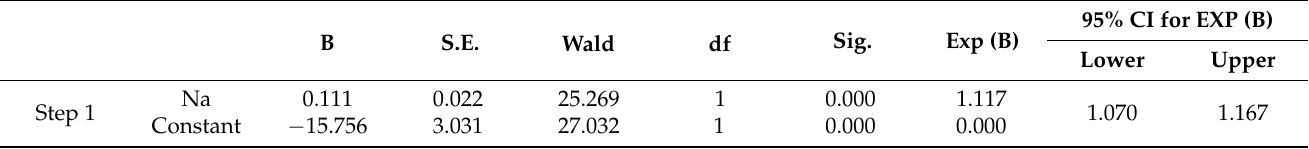
Figure 2. ROC curve for the discriminative ability of the prognostic scores to detect the presence of variceal bleeding in patients with liver cirrhosis. Table 6. Correlation between serum sodium value and variceal bleeding.